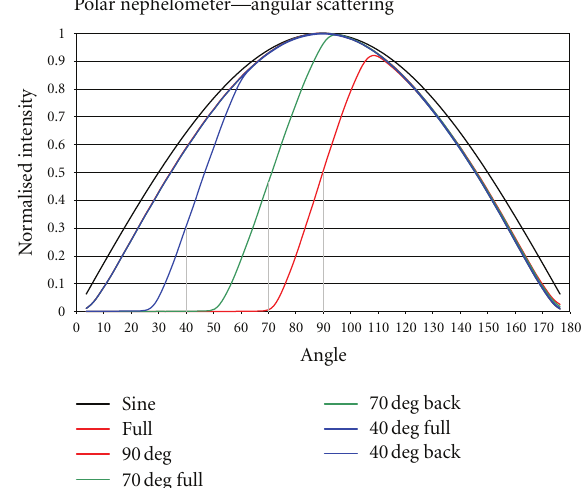
FIGURE 3: Graphical demonstration of backscatter measurements at 40 ◦ , 70 ◦ , and 90 ◦